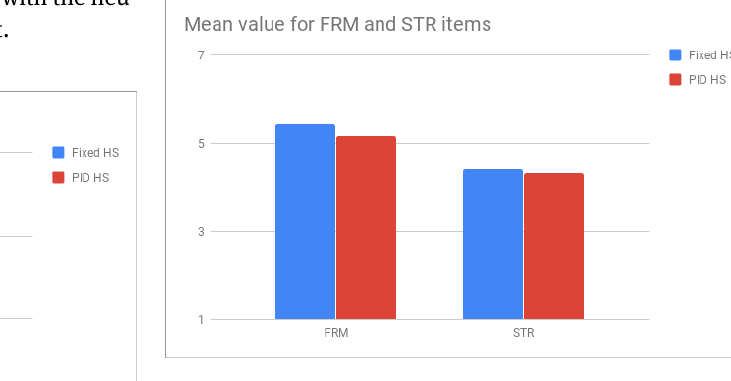
Figure 11: Mean values for firmness and strength items.